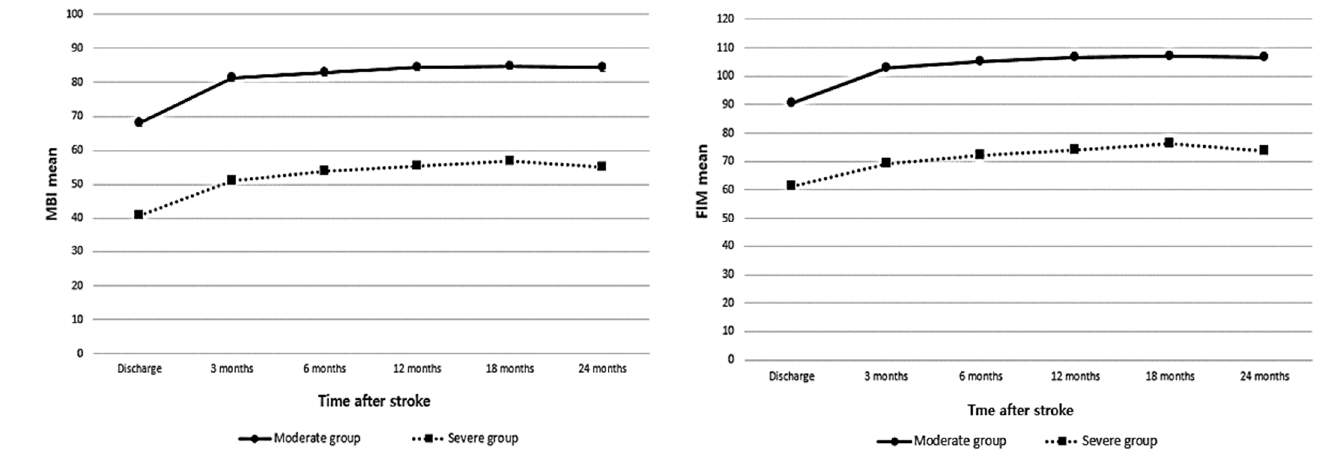
Figure 2. Changes in total MBI and FIM scores in moderate and severe patients.